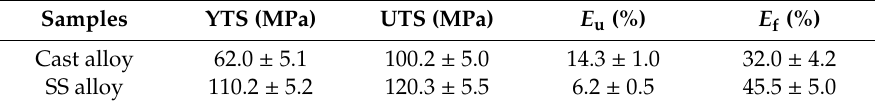
Table 2. Tensile data before and after solution treatment of Mg-9Li